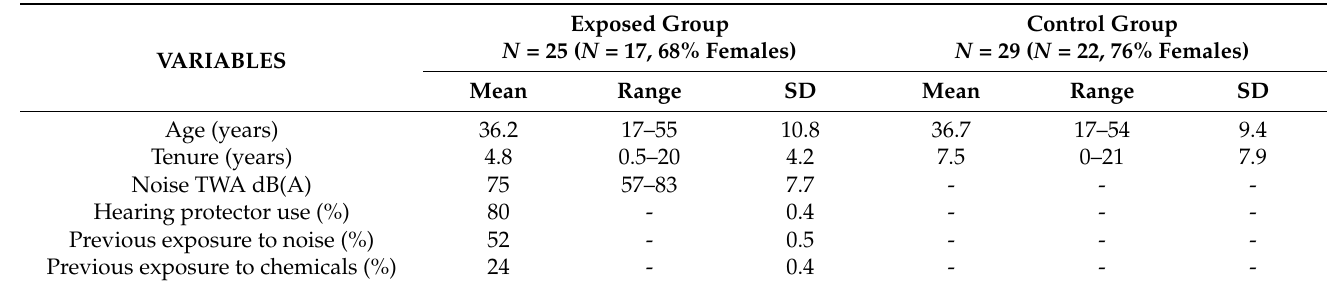
Table 2. Characterization of the study sample by exposure